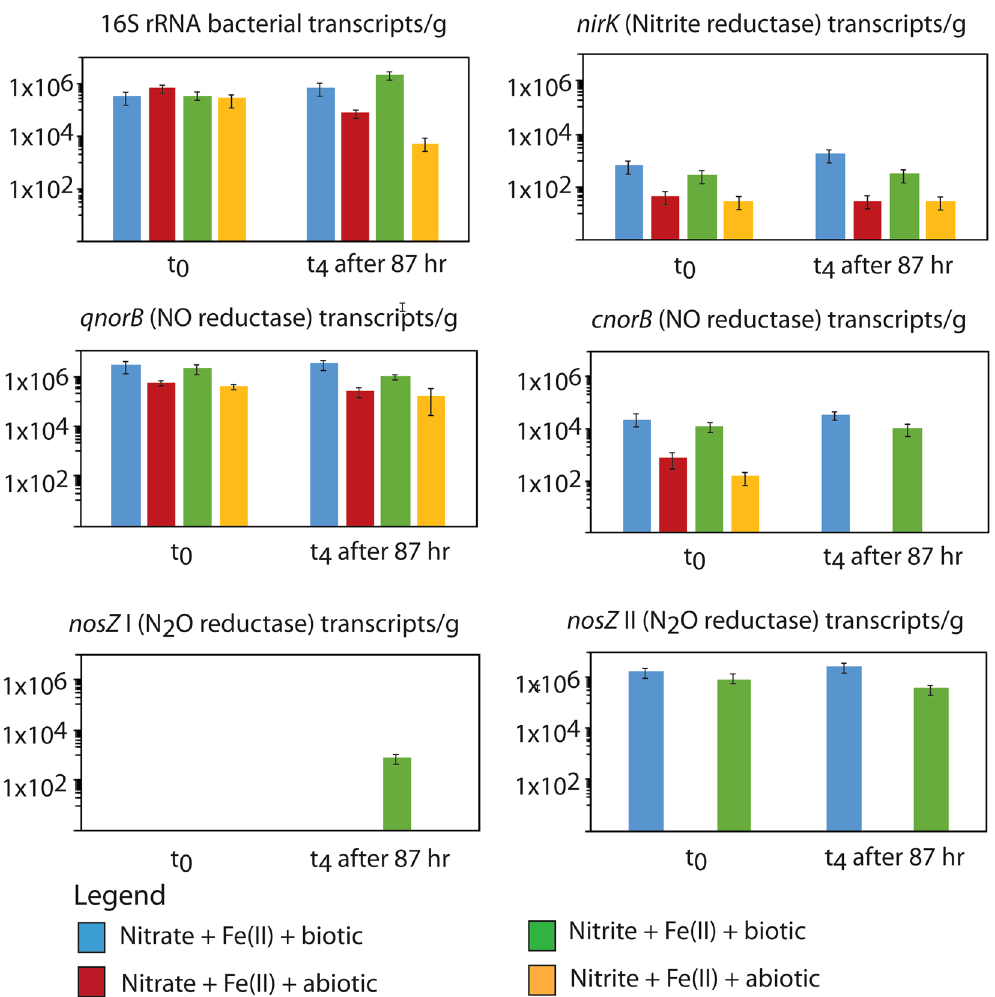
Figure 3. Absolute abundance of bacterial 16S rRNA and nitrogen cycle transcripts in biotic and abiotic microcosms (shown in Fig. 1). Transcripts in abiotic experiments were detectable. RNA might be stable due to inactivated RNAse by gamma-rays 41 . Results based on DNA sequences are shown in Fig. S4. Results shown are average of three parallel microcosm setups. Standard deviation is based on biological triplicates (triplicate microcosm setups). g = gram wet weight. nosZ I = typical nosZ , clade I nosZ ; nosZ II = atypical nosZ , clade II nosZ